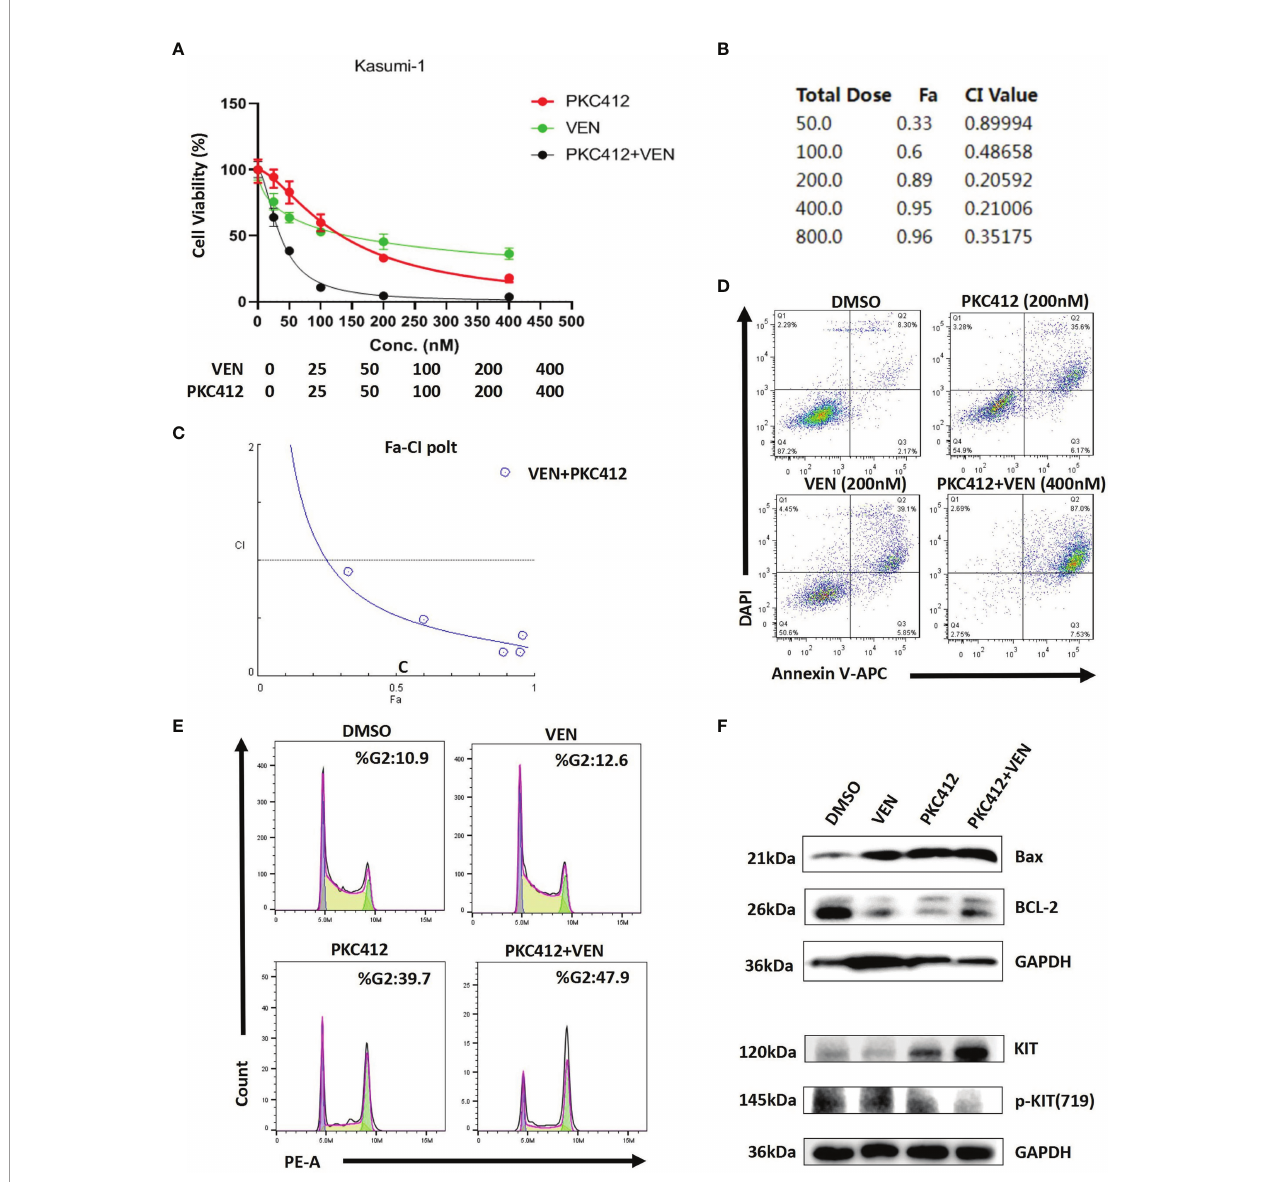
FIGURE 2 | Venetoclax (VEN) synergizes with midostaurin (PKC412) to inhibit proliferation and induce apoptosis in Kasumi-1 cells. (A) The curve represents the dose- dependent effects of VEN and PKC412 on cell proliferation at 72 h. (B, C) Fa-CI plot and combination index (CI) values were calculated with CompuSyn software. CI < 1 indicates synergy, CI = 1 is additive, and CI > 1 indicates antagonism. The results showed that VEN combined with PKC412 had the most notable synergistic effect. (D) PKC412 induced apoptosis in Kasumi-1 cells and cooperatively induced apoptosis with VEN. Apoptosis was determined by Annexin-V/DAPI staining after Kasumi-1 cells were treated with PKC412 alone and in combination with VEN at the indicated concentrations for 72 h. (E) Kasumi-1 cells was treated with PKC412 and/or VEN at indicated concentration (500nM) for 72 h, and cell cycle analysis was performed by fl ow cytometry. (F) Kasumi-1 cells were exposed to PKC412 and/or VEN at 1 m M for 72 h (BCL-2 and Bax) and 500nM for 8 h (KIT and p-KIT), then subjected to Western blotting. GAPDH was measured as a loading